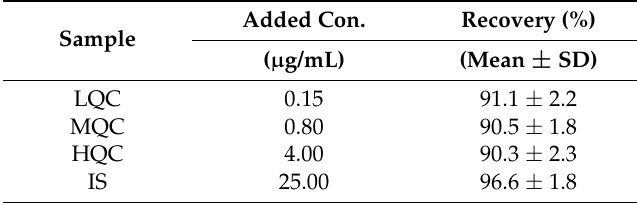
Table 3. Recovery of CMME and IS in dog plasma ( n = 5). Added Sample